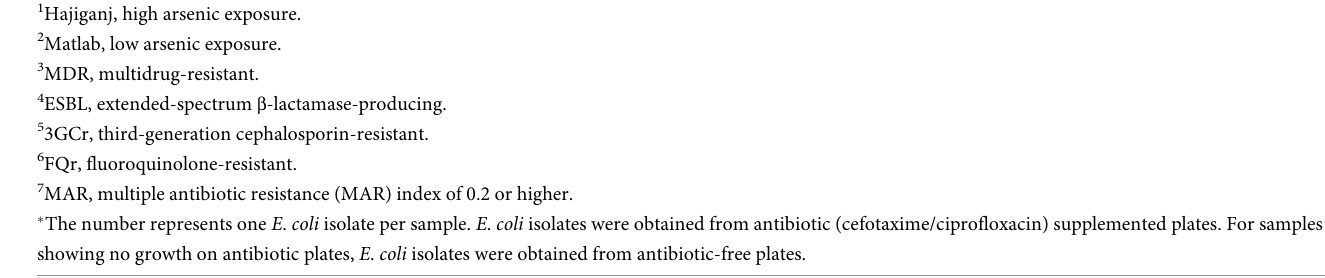
Hajiganj Matlab p ( n = 48) ( n = 43)